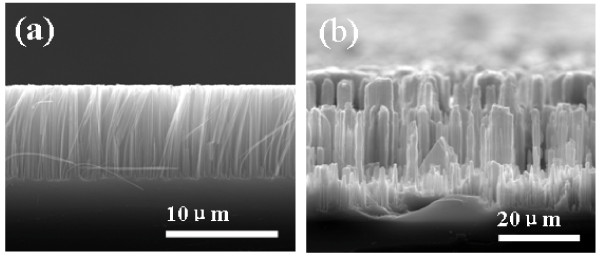
Cross-sectional SEM images of silicon samples. (a) Etched in the solution containing 4.6 M HF, 0.02 M AgNO3, and 0.005 M KMnO4 for 45 min. (b) Cross-sectional SEM images of n-Si(100) with the resistivity of 3 cmto 5 Ω·cm etched in the solution containing 4.6 M HF, 0.02 M AgNO3, and 0.05 M KMnO4 for 45 min.